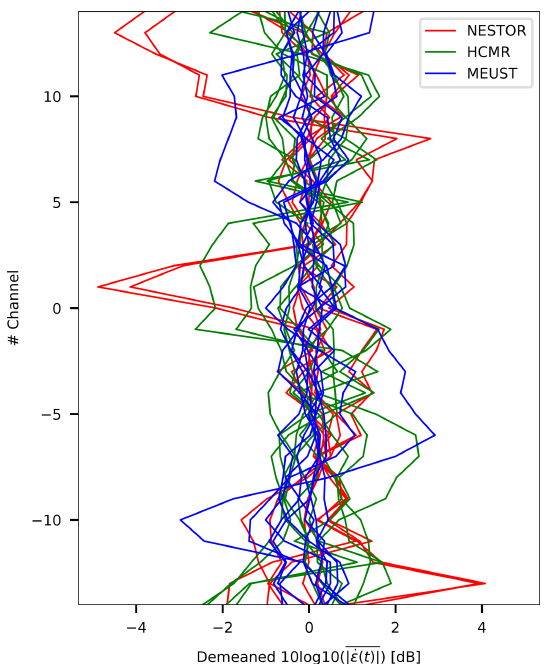
Figure 14. Signal amplitude variability for all analyzed fiber seg- ments for the three cables. Number of channels along the lim- ited segments (29 traces) as a function of demeaned 10log 10 (X) with X being the average absolute strain-rate amplitudes. Data for NESTOR, HCMR and MEUST are plotted in red, green and blue,